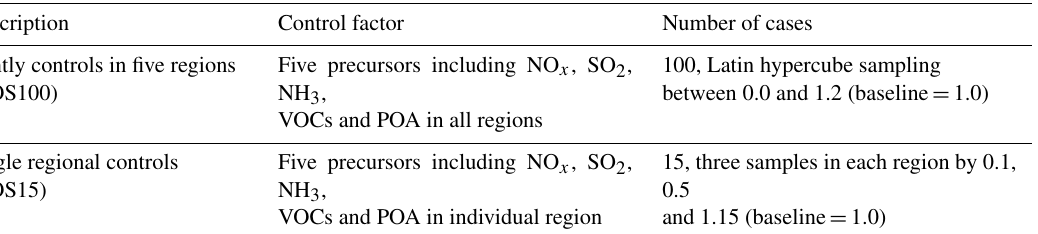
Five precursors including NO x , SO 2 , NH 3 , VOCs and POA in all regions Five precursors including NO x , SO 2 , NH 3 , VOCs and POA in individual region